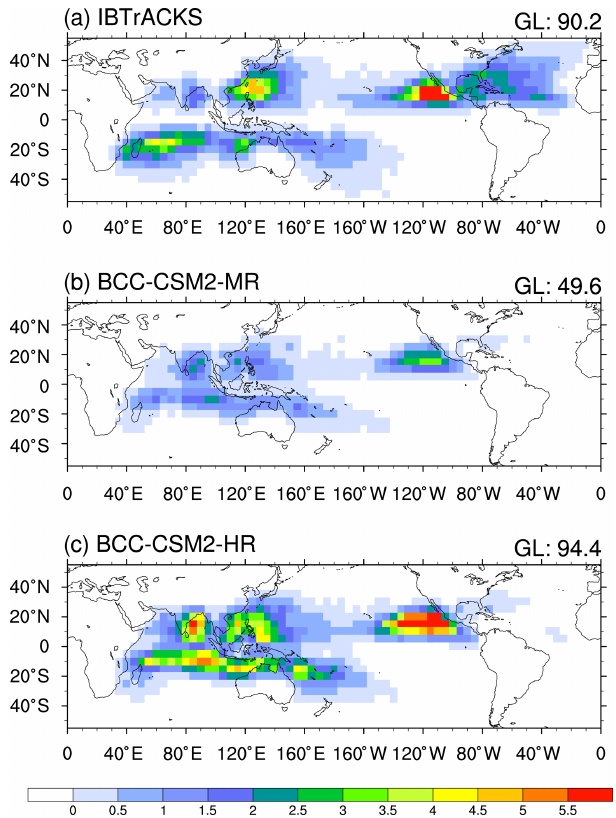
Figure 14. The global distribution of tropical cyclone (TC) den- sities (number per year) averaged for the period of 1995–2014 from (a) the IBTrACS_wmo observations, and the simulations of (b) BCC-CSM2-MR and (c) BCC-CSM2-HR. The value in the upper-right corner denotes the total number of global TCs on 5 ◦ × 5 ◦ grid box.